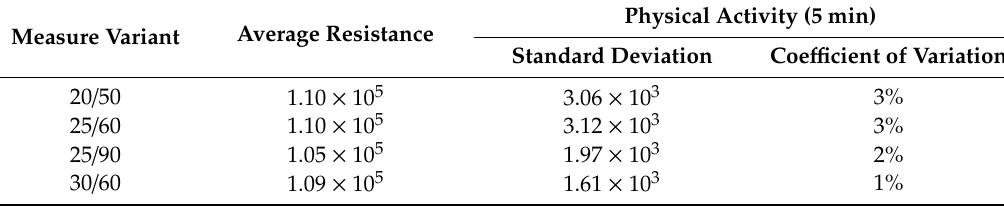
Table 4. Average number of breaths per minute.